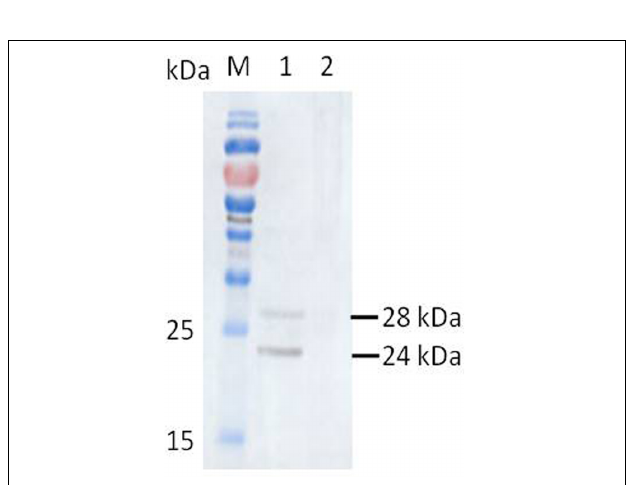
FIGURE 4 | Western blot analysis for native protein of parasites. M, PageRuler prestained protein ladder; (1) RBCs from mice infected with B. microti ; (2) RBCs from mice uninfected with B. microti .